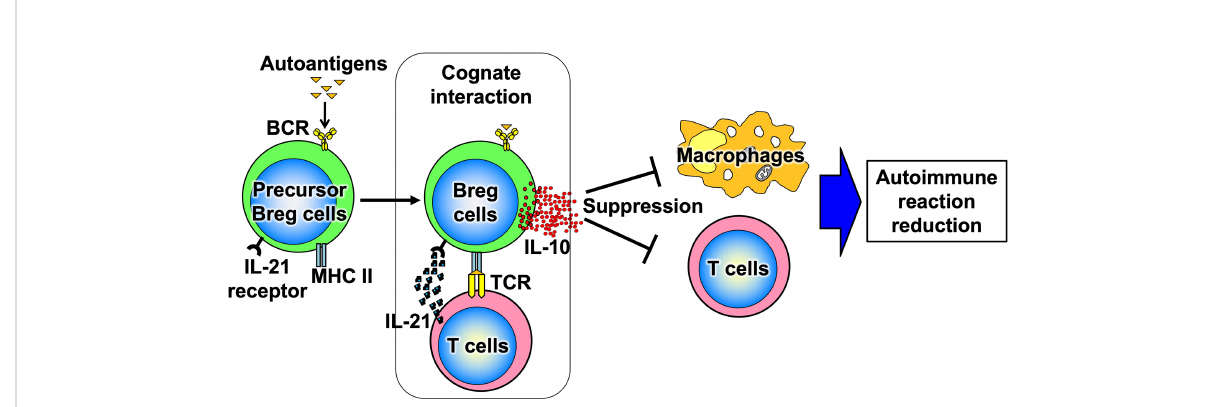
FIGURE 4 Antigen-speci fi c effects of Breg cells. When Breg cell progenitors encounter autoantigens, they differentiate and produce IL-10. Thus, Breg cells suppress excessive immune responses in an antigen-speci fi c manner.